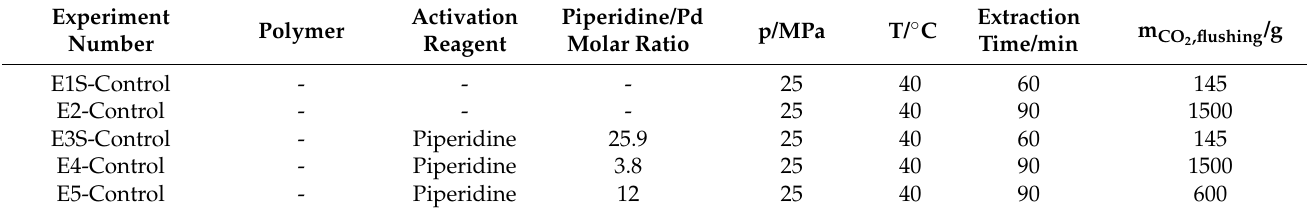
Table 1. Extraction parameters for control tests (ExS-Control: Screening experiments; Ex-Control: Detailed investigation